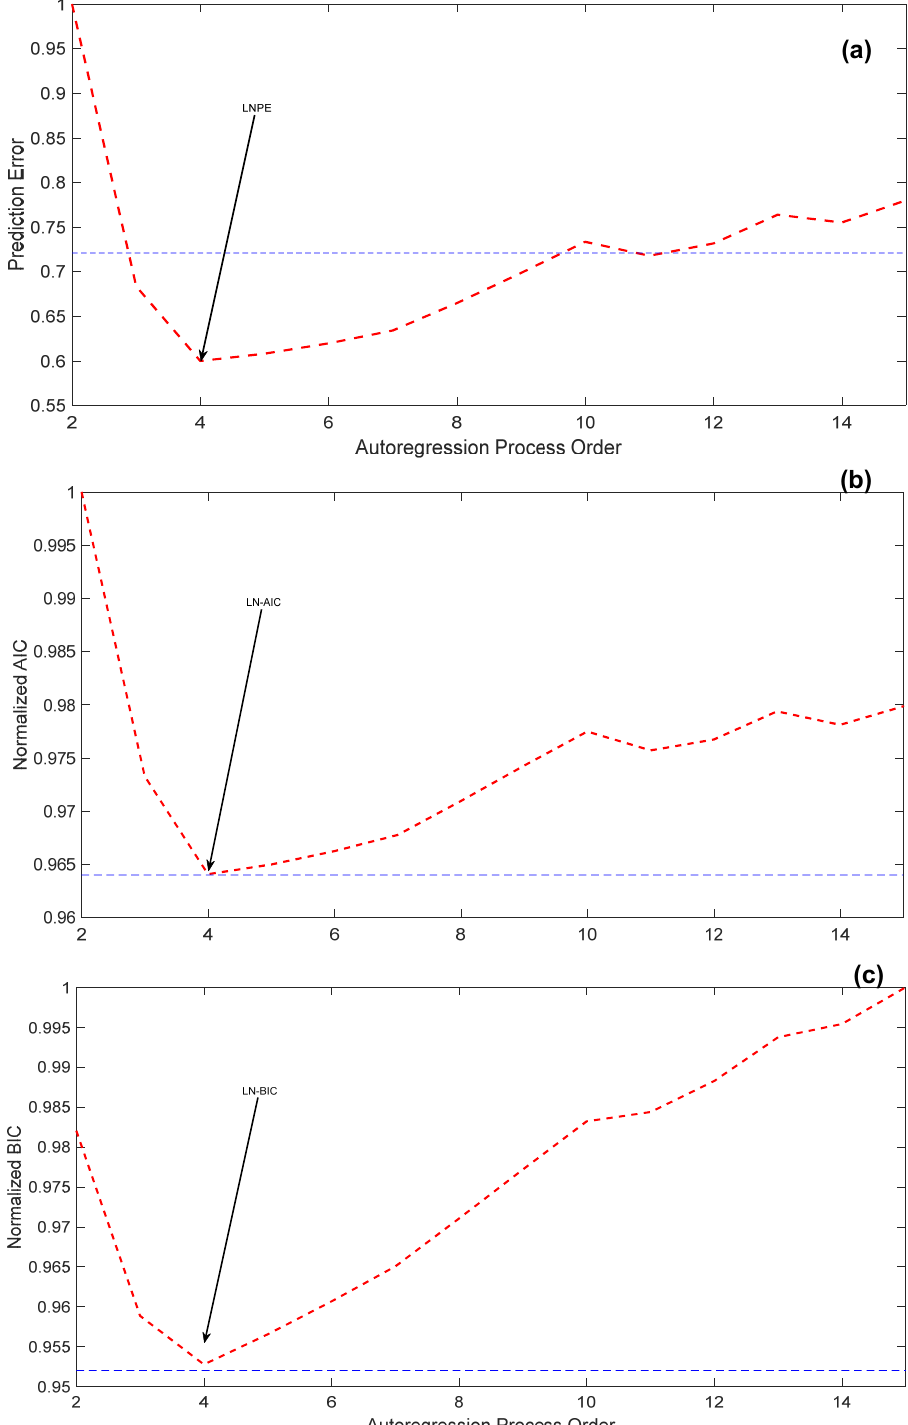
Figure 5. ( a ) Relationship between normalized prediction error and the regressing scheme order. ( b ) Relationship between Akaike information criterion (AIC) and the regressing scheme order. ( c ) Relationship between Bayesian information criterion (BIC) and the regressing scheme order. alizing the original time series vs. the regressed time series using (cid:1827)(cid:1844)(4) process along